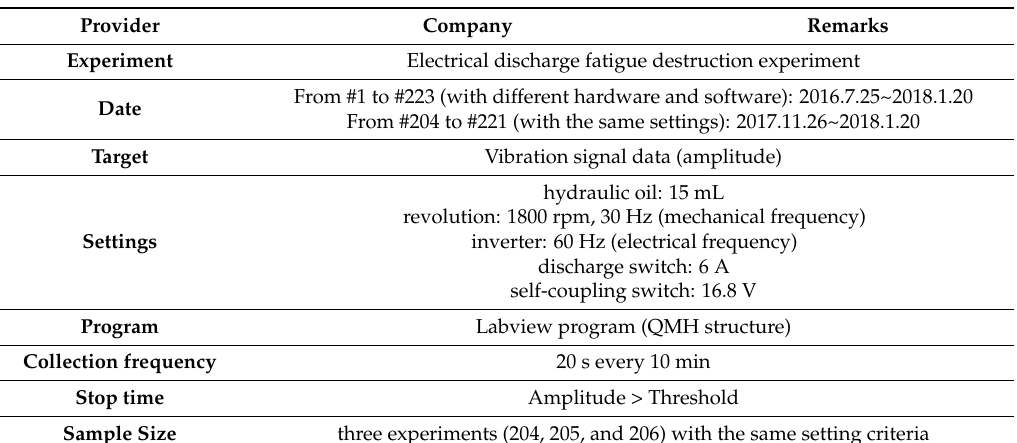
Table 1. Data sources.